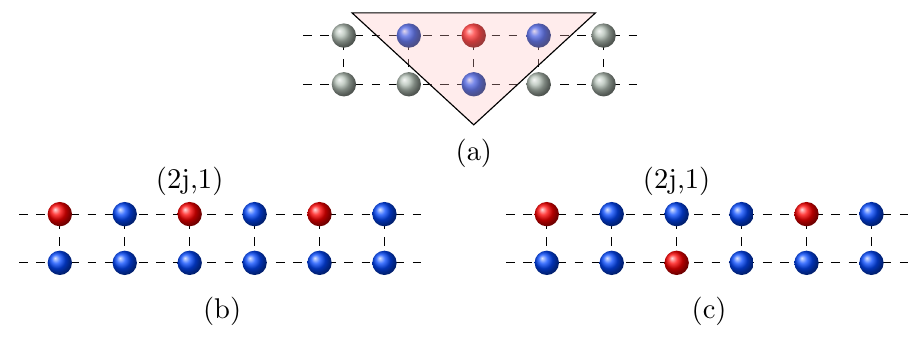
Figure 1: (a) Schematic representation of a two-leg Rydberg ladder. The circles rep- resent sites on the Rydberg chain. The presence of a Rydberg excitation on a site is denoted by the red circle; this precludes excitations of nearby sites (denoted by blue circles). The corresponding Rydberg blockade radius is schematically shown by the triangle. The other sites (grey circles) may have Rydberg excitations since they would experience weaker repulsive vdW interaction falling off as 1 / | ⃗ r | 6 with distance | ⃗ r | from the site with a Rydberg excited atom (red circle). (b) Schematic represen- tation of one of the states with Rydberg excitation density n = 1 / 4 with excitations occurring at even sites of one of the ladders. This state is one of the two possible classical Fock states which represents the ground state for λ > λ . (c) A similar dia- c gram for a state in the low-energy manifold with n = 1 / 4 whose superposition forms the ground state at λ < λ but not for λ > λ . See text for c c